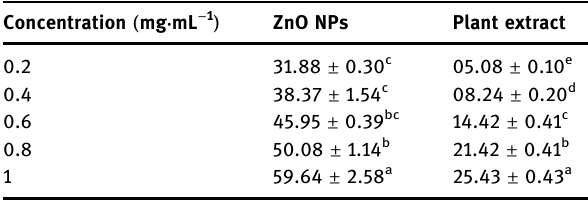
Values are the means of four independent replicates. ± indicate standard errors. Means followed by the same letter ( s ) within the Tukey ’ s